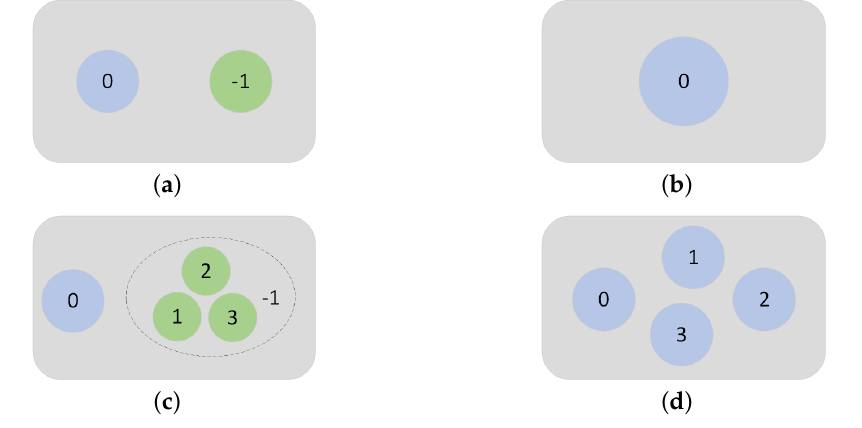
Figure 1. Different data settings. ( b ) stands for unsupervised settings, ( a , c , d ) represent three forms of supervised setting respectively. Blue area denotes normal samples, green denotes anomalous or outlier samples, grey denotes unavailable samples.In Figure 1a, the marked normal data and abnormal data are given, which belongs to the supervised learning method. In Figure 1b, only normal samples are given, and no abnormal samples are given. In Figure 1c, marked normal samples and unmarked abnormal samples are given. In Figure 1d, the labeled normal samples are given, and the abnormal samples are not given. The above three categories belong to unsupervised